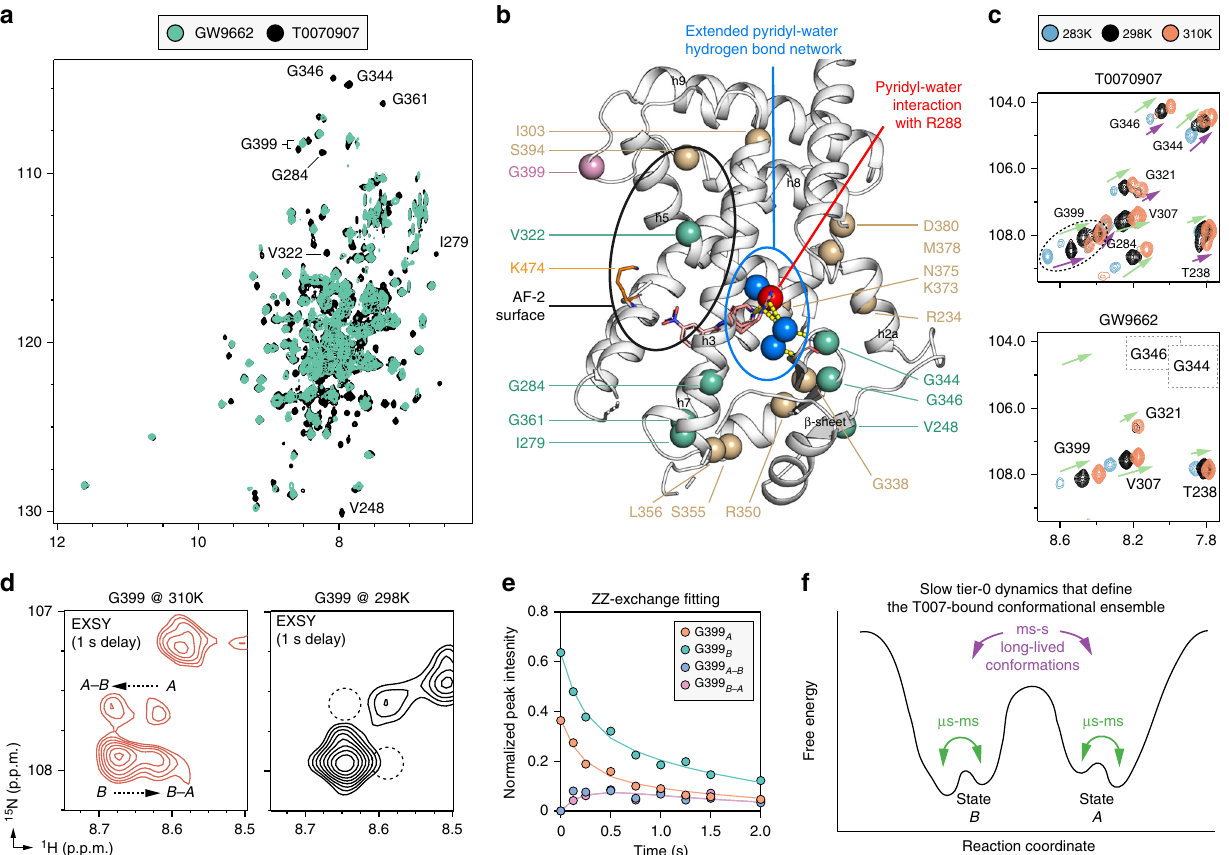
Fig. 5 NMR detected exchange between two long-lived T0070907-bound conformations. a Overlay of 2D [ 1 H, 15 N]-TROSY-HSQC NMR spectra of 15 N- labeled PPAR γ LBD bound to GW9662 or T0070907. b Binding of T0070907 but not GW9662 stabilizes intermediate exchange ( µ s-ms time scale) dynamics (residues labeled in a shown in green spheres) and causes peak doubling (tan and pink spheres; G399 is colored pink for emphasis). Data plotted on the T0070907-bound PPAR γ crystal structure and important structural regions are highlighted as follows: AF-2 surface (black oval); an extended pyridyl-water hydrogen bond network (blue spheres, yellow dotted lines, blue oval), beyond the key pyridyl-water interaction (red sphere). c Snapshot overlays of 2D [ 1 H, 15 N]-TROSY-HSQC spectra of 15 N-labeled PPAR γ LBD bound to T0070907 or GW9662 shows co-linear shifting of peaks at the different temperatures. The spectral region displayed shows peaks conserved when PPAR γ is bound to GW9662 or T0070907 (green arrows); a unique set of doubled peaks when bound to T0070907 (purple arrows); and absent peaks due to intermediate exchange on the NMR time scale when bound to GW9662 (dotted rectangles). d Snapshots of ZZ-exchange [ 1 H, 15 N]-HSQC NMR spectra (delay = 1 s) of T0070907-bound 15 N-labeled PPAR γ LBD focused on G399 at the indicated temperatures. Two G399 conformational states are denoted as A and B with the ZZ-exchange transfer crosspeaks as A – B and B – A. e ZZ-exchange NMR analysis build-up curve from for G399 at 310 K generated by plotting peak intensities of the state A and B peaks and exchange crosspeaks (A – B and B-A) as a function of delay time. f Schematic of the T0070907-bound PPAR γ conformational ensemble de fi ned by